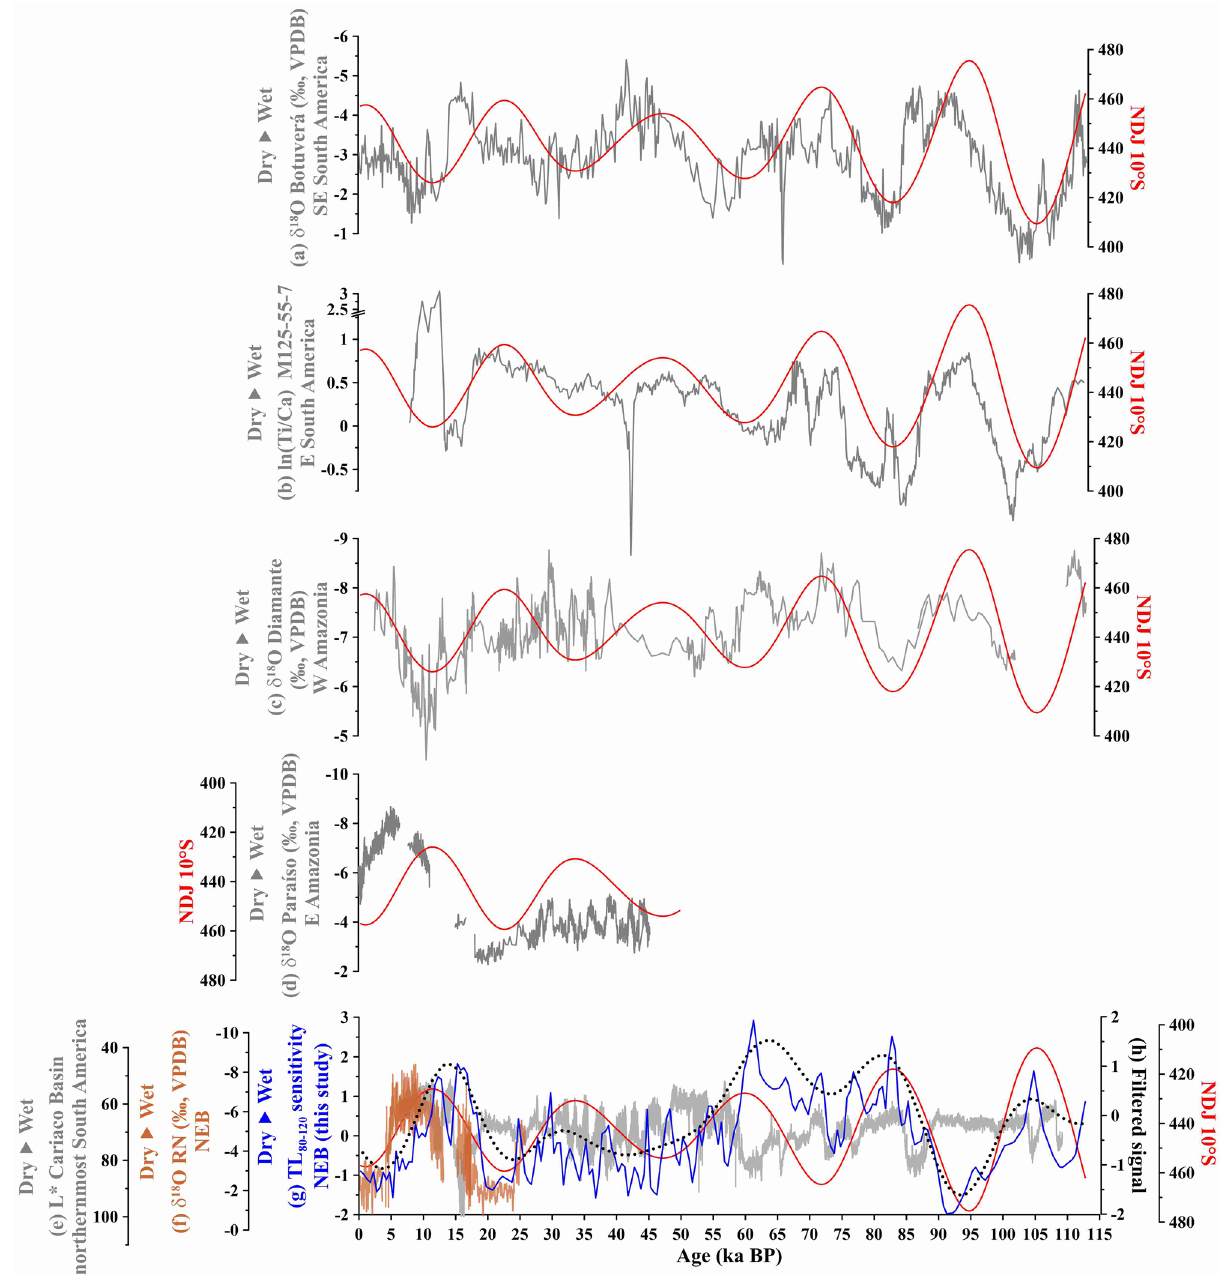
Figure 3. New northern NE Brazil (NEB) precipitation record together with other records from (sub)tropical South America. ( a ) Speleothem stable oxygen isotopic (δ 18 O) record from Botuverá Cave, southeastern (SE) South America (27.2°S, 49.2°W) 29 . ( b ) ln(Ti/Ca) from marine sediment core M125-55–7, off eastern (E) South America (20.4°S, 38.6°W; the axis was broken from 1.25 to 2.5) 31 . ( c ) Speleothem δ 18 O records from Diamante Cave, western (W) Amazonia (ca. 5°S, 77°W) 5 . ( d ) Speleothem δ 18 O record from Paraíso Cave, eastern (E) Amazonia (4.67°S, 55.45°W) 14 . ( e ) L* reflectance from the Cariaco Basin marine sediment core MD03-2621, off northernmost South America (10.7°N, 65°W) 28 . ( f ) Speleothem δ 18 O records from Rio Grande do Norte (RN) caves, NEB (5.6°S, 37.7°W) 6 . ( g ) Thermoluminescence (TL 80–120 ) sensitivity of the 110 °C peak from marine sediment cores GL-1248 (0.92°S, 43.40°W) and GeoB16206-1 (1.58°S, 43.02°W) 21 , off NEB (this study). ( e ) TL record filtered in 0.026 ka frequency (19 ka, FIR filter) within software PAST v4.03 46 . Red curves are November– January (NDJ) insolation (W/m 2 ) at 10°S 47